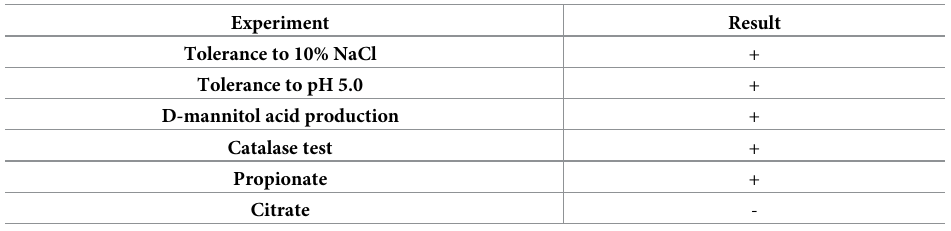
Table 3. Physiological and biochemical analysis of the DW-7 bacterial strain.